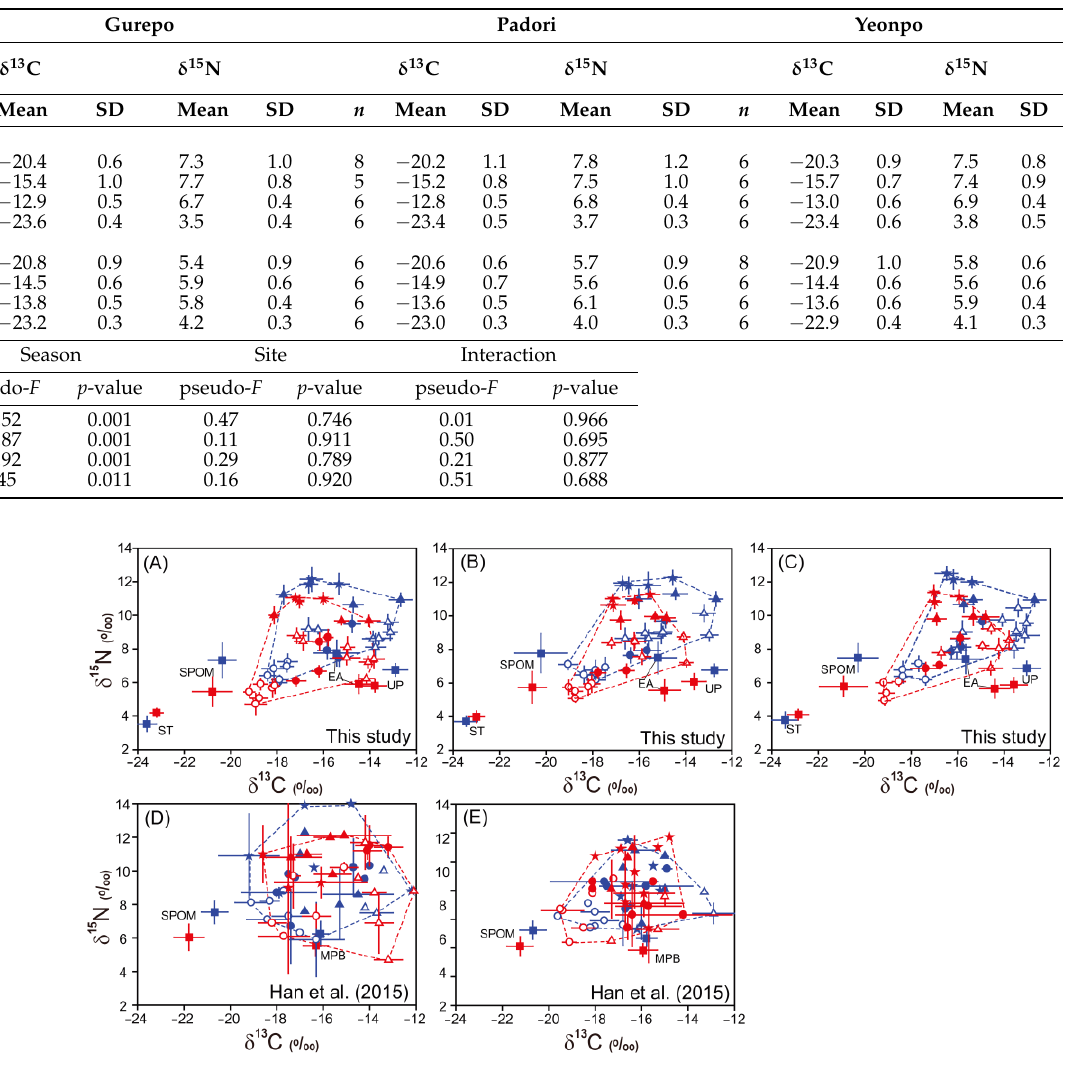
Figure 2. Dual isotope plots of δ 13 C and δ 15 N values of consumers (empty circles, suspension feeders; filled circles, deposit feeders; empty triangles, grazers; filled triangles, omnivores; stars, carnivores) at the three oil-contaminated sites (( A ), Gurepo; ( B ), Padori; ( D ), Malipo) and two non-impacted reference sites (( C ), Yeonpo; ( E ), Mongsanpo) in July (blue color) and November (red color) for this study and in spring and summer for [17]. Values of the potential food sources are illustrated by filled squares. SPOM, suspended particulate organic matter; EA, epilithic algae; UP, microphytobenthos; MPB Ulva pertusa ; ST, Sargassum thunbergii . Values are means (‰) ± 1 standard deviation. Table 2. Mean δ 13 C and δ 15 N values of macrobenthic consumers collected at the two heavily oil- impacted (Gurepo and Padori) and one non-impacted reference (Yeonpo) sites in July and Novem- ber. Data represent means ± 1 SD. Taxa: B, bivalvia; C, crustacea; E, echinodermata; G, gastropoda; P, polychaeta; Pp, polyplacophora.